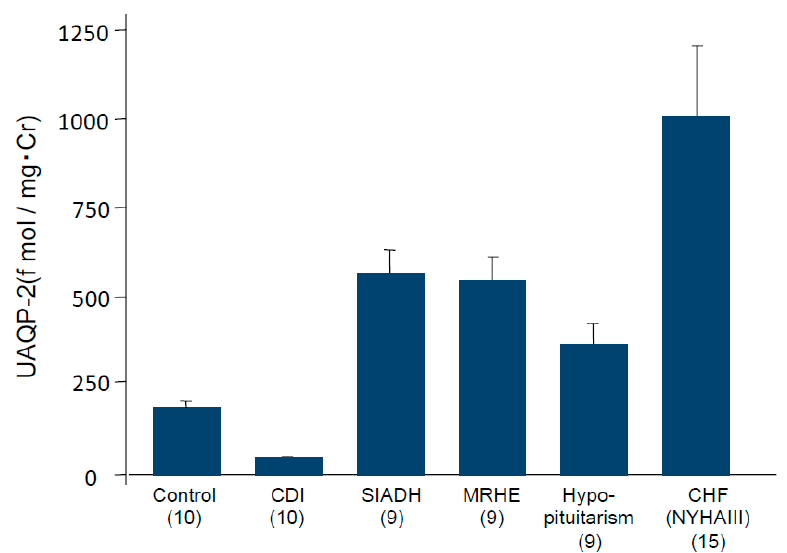
Figure 3. Elevation of urinary excretion of aquaporin 2 (UAQP2) in patients with impaired water excretion. The numbers of patients are shown in brackets.